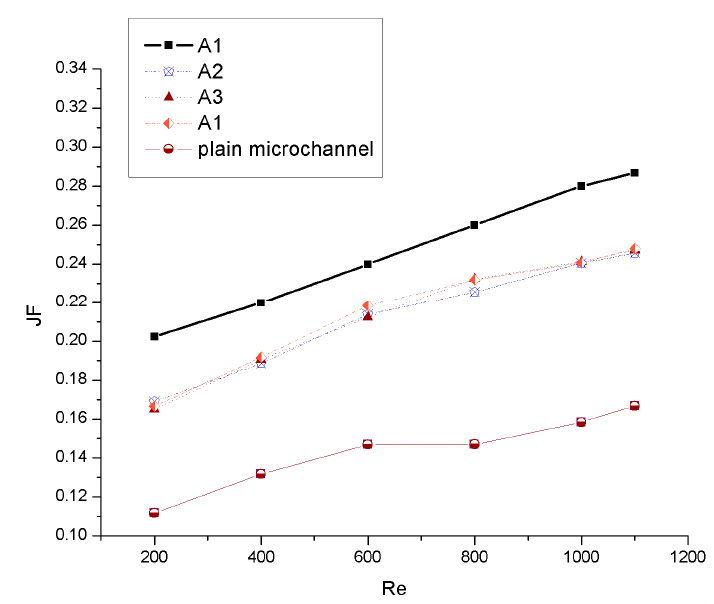
Figure 11. JF factor versus Reynolds number for various microchannel configurations.